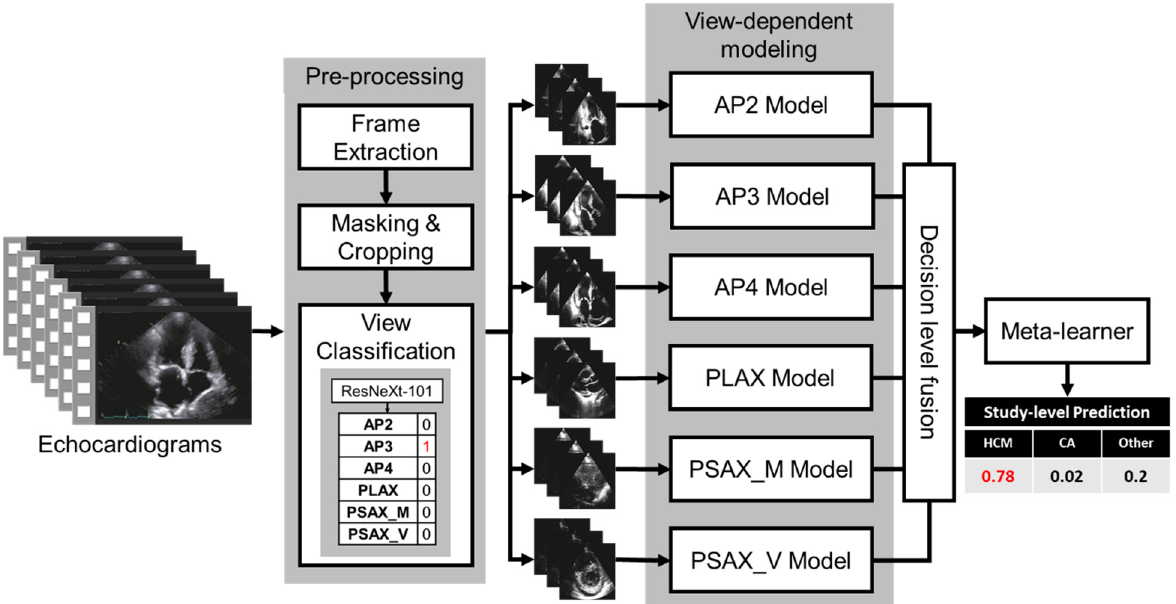
Figure 1. The architecture of the fusion model. Blocks represent the processing modules. AP2: Apical 2 Chamber, AP3: Apical 3 Chamber, AP4: Apical 4 Chamber, PLEX: parasternal long axis, PSAX_M: parasternal short-axis view, at the mid-ventricular level, PSAX_V: parasternal short-axis view, at the valve level levels.